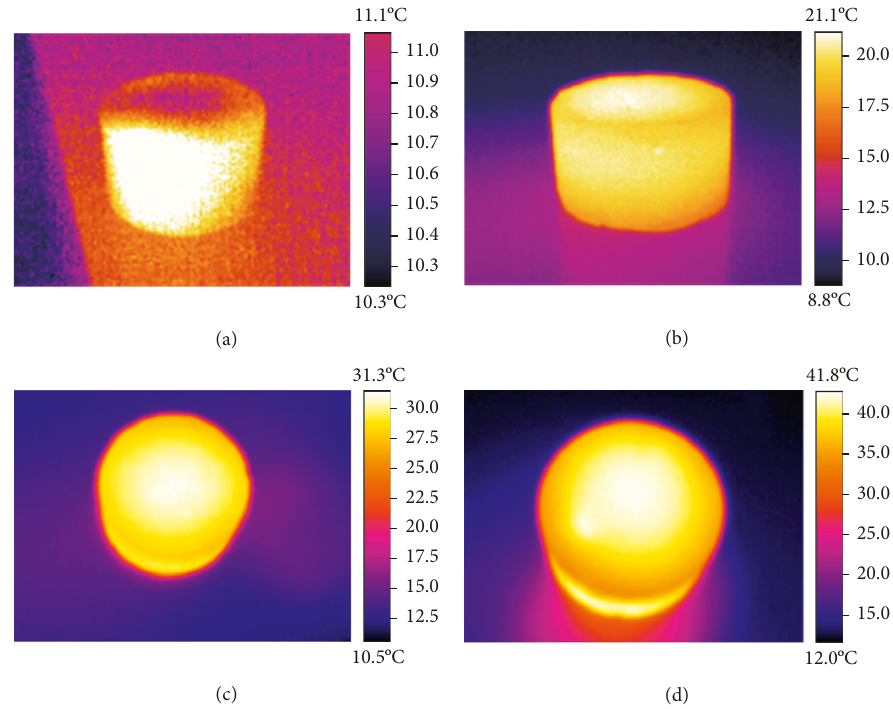
Figure 6: Infrared pictures of graphite concrete under different environmental temperatures. (a) 10 ° C. (b) 20 ° C. (c) 30 ° C. (d) 40 °